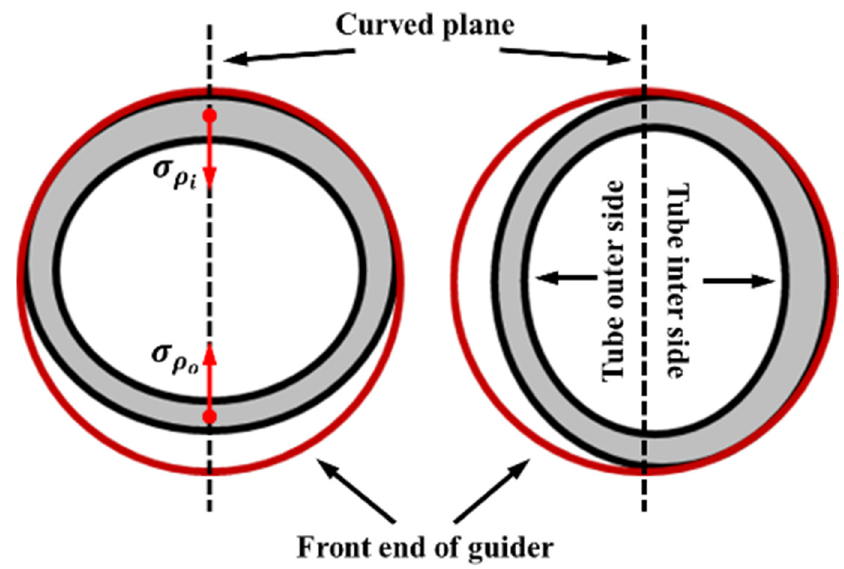
Figure 9. Schematic diagram of cross-sectional shape redistribution.